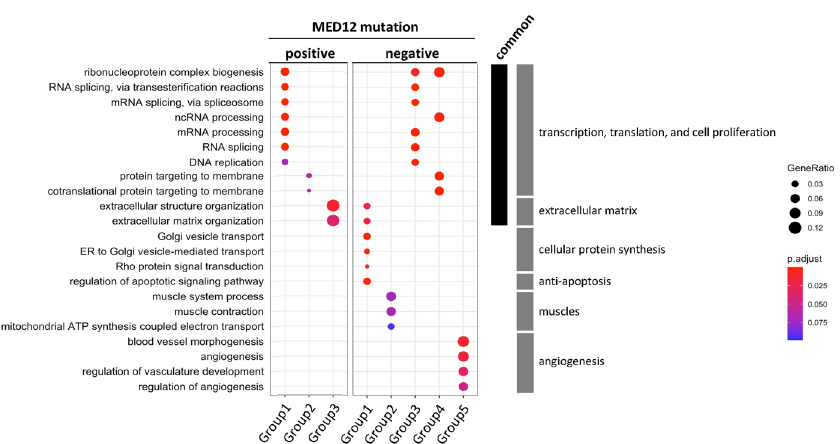
Figure 4. Enriched GO terms identified by weighted gene co-expression network analysis (WGCNA) in the MED12m-positive and -negative uterine fibroids. Twenty-six and 14 COGs groups in the MED12m-positive and -negative uterine fibroids, respectively, were introduced into the pathway and GO enrichment analyses. Three and five COGs groups in the MED12m-positive and -negative uterine fibroids were significantly enriched with GO terms. The other 23 and 9 COGs groups in the MED12m-positive and -negative uterine fibroids, respectively, were not significantly enriched with GO terms. The ratio of the number of identified genes to all genes in each term is shown as "geneRatio". P-values were adjusted with the BH method by clusterProfiler 36 and indicated with